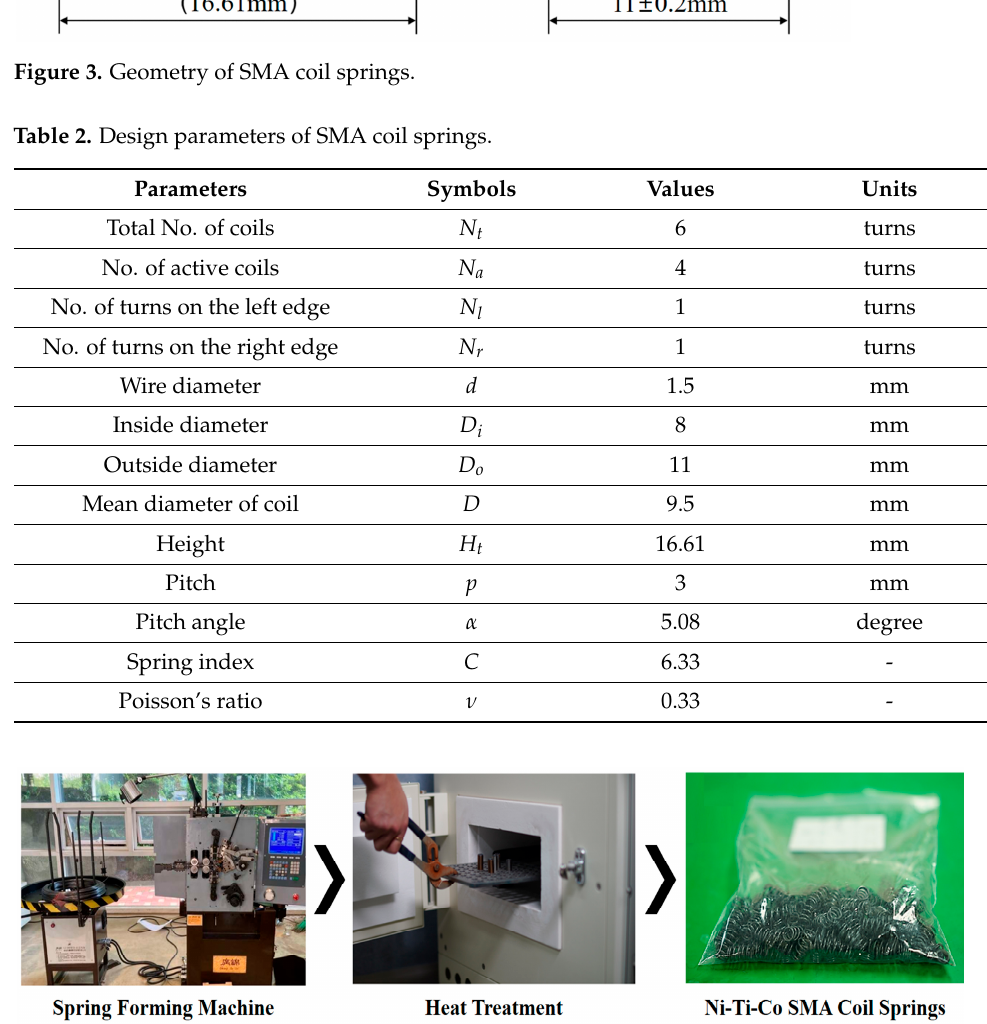
Figure 4. Fabrication process of Ni-Ti-Co SMA coil